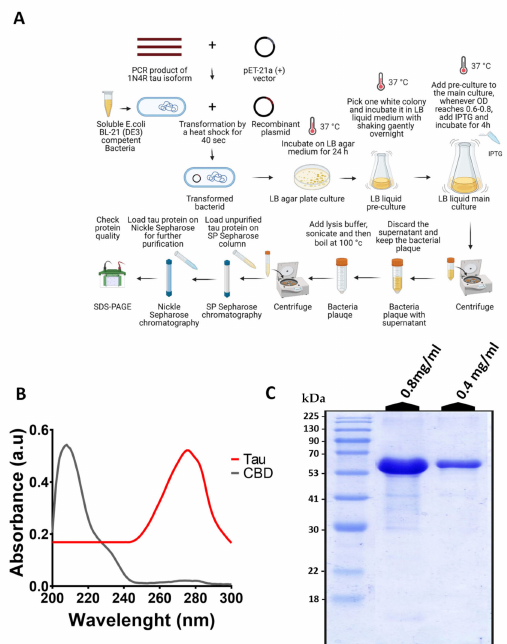
Figure 1. In vitro generation of human his-tagged tau protein. ( A ) Scheme of the main steps of his-tagged 1N4R tau protein production using the pET-21a (+) expression vector in Escherichia coli BL21 and purification by Ni-NTA and SP Sepharose columns. ( B ) The absorbance of extracted tau protein with a peak at 280 nm and the absorbance of CBD with a peak at 207 nm by UV-visible spectroscopy. It indicates that there is no interference between CBD and tau protein absorbance. ( C ) The quality of purified tau protein using SDS-PAGE. Representative SDS-PAGE of purified tau protein (~59 kDa) at two different concentrations of 0.8 mg/mL and 0.4 mg/mL. The same trends were detected in the SDS-PAGE data of at least three independent samples ( n =